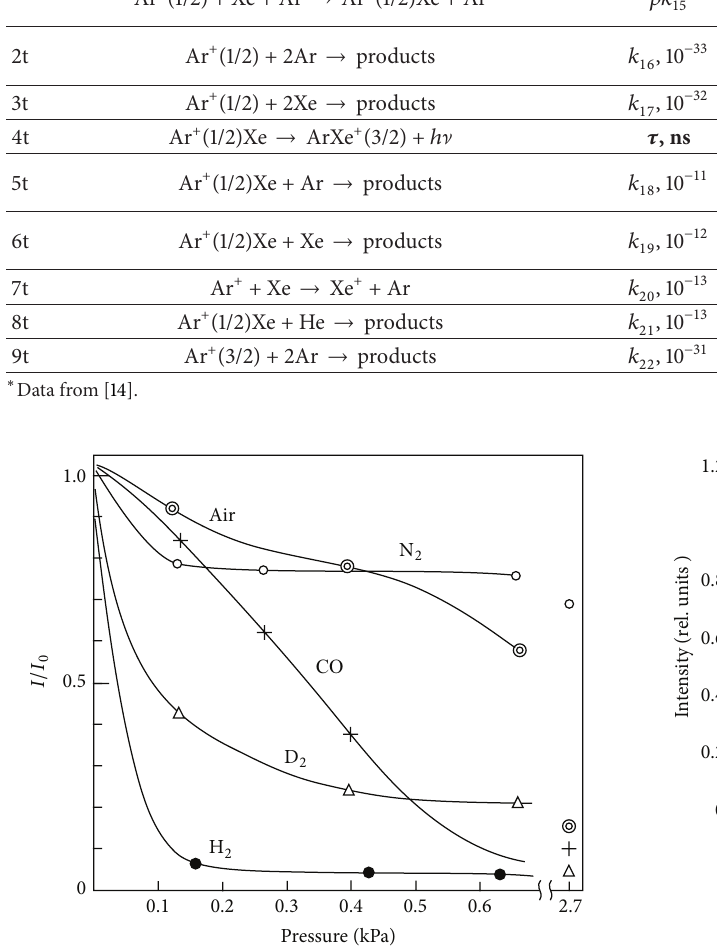
Figure 8: Dependence of the intensity of radiation at 𝜆 = 490 nm on the pressure additives to the mixture Kr(55 kPa)-Xe(55kPa).